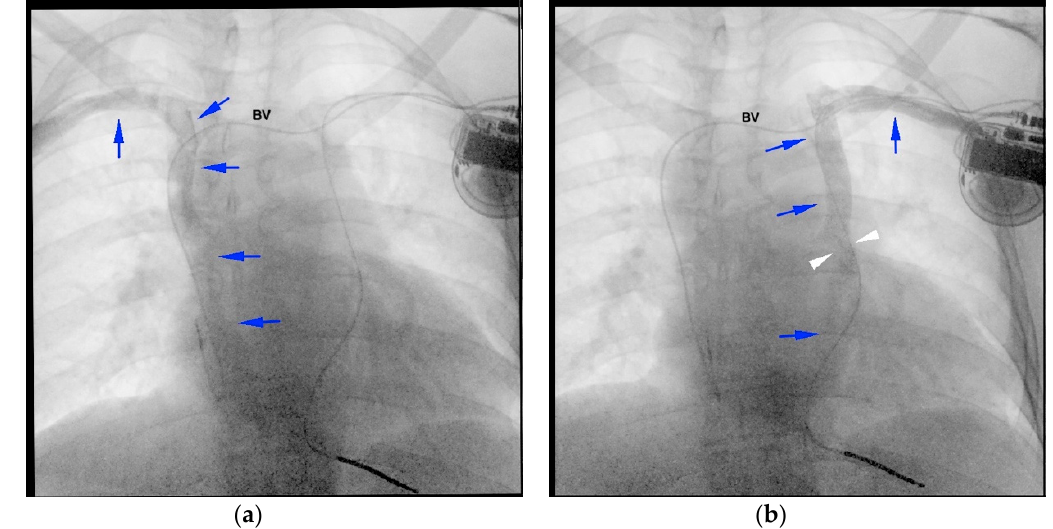
Figure 5. ( a ) Venography: right superior vena cava (SVC) draining into the right atrium (blue arrows); obstruction of the brachiocephalic vein (BV) with no contrast flow; ( b ) venography: left SVC draining in the right atrium via the coronary sinus (blue arrows); obstruction of the BV, with no contrast flow; residual stenosis/kinking at the border between left SVC and CS (white arrowheads).